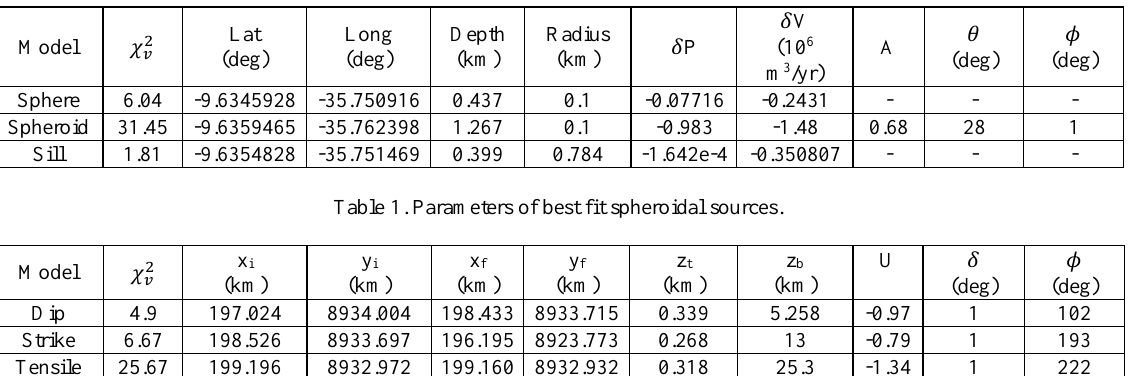
Table 2. Parameters of the best fit rectangular dislocation models. Dip, strike and tensile refers to the movement direction. Parameter U<0 means normal, left lateral and closing motion. δ and ϕ are the inclination and strike direction,